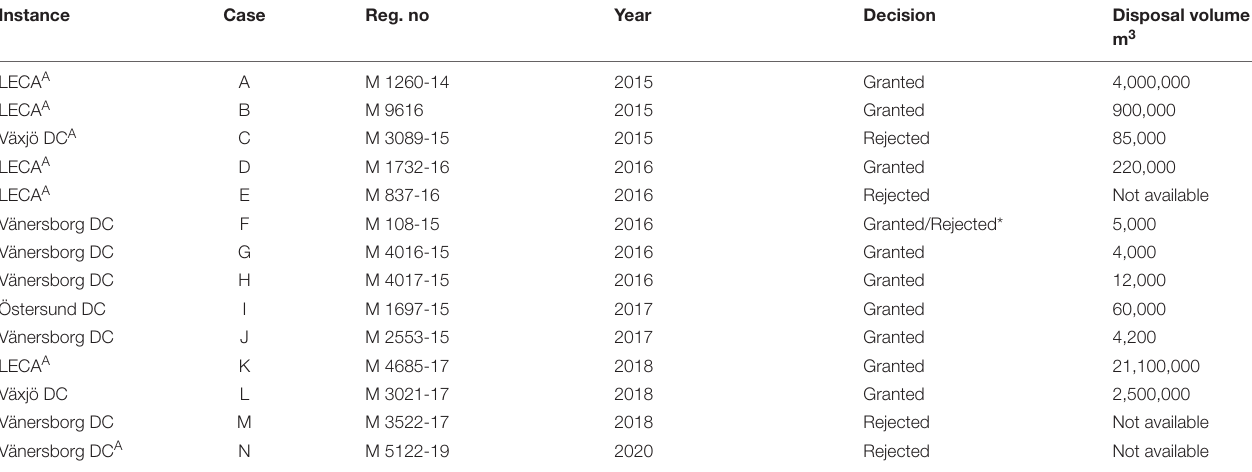
FIGURE 1 | Involved actors in Sweden and their engagement in relation to applications for exemption to dumping dredged sediment at sea. TABLE 1 | Cases by land and environmental District Courts (DC) or the Land and Environmental Court of Appeal (LECA), processing applications or appeals to exemption from the ban on dumping waste at